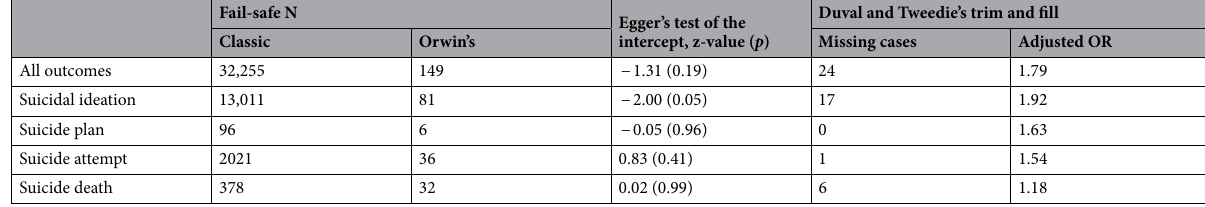
Table 2. Publication